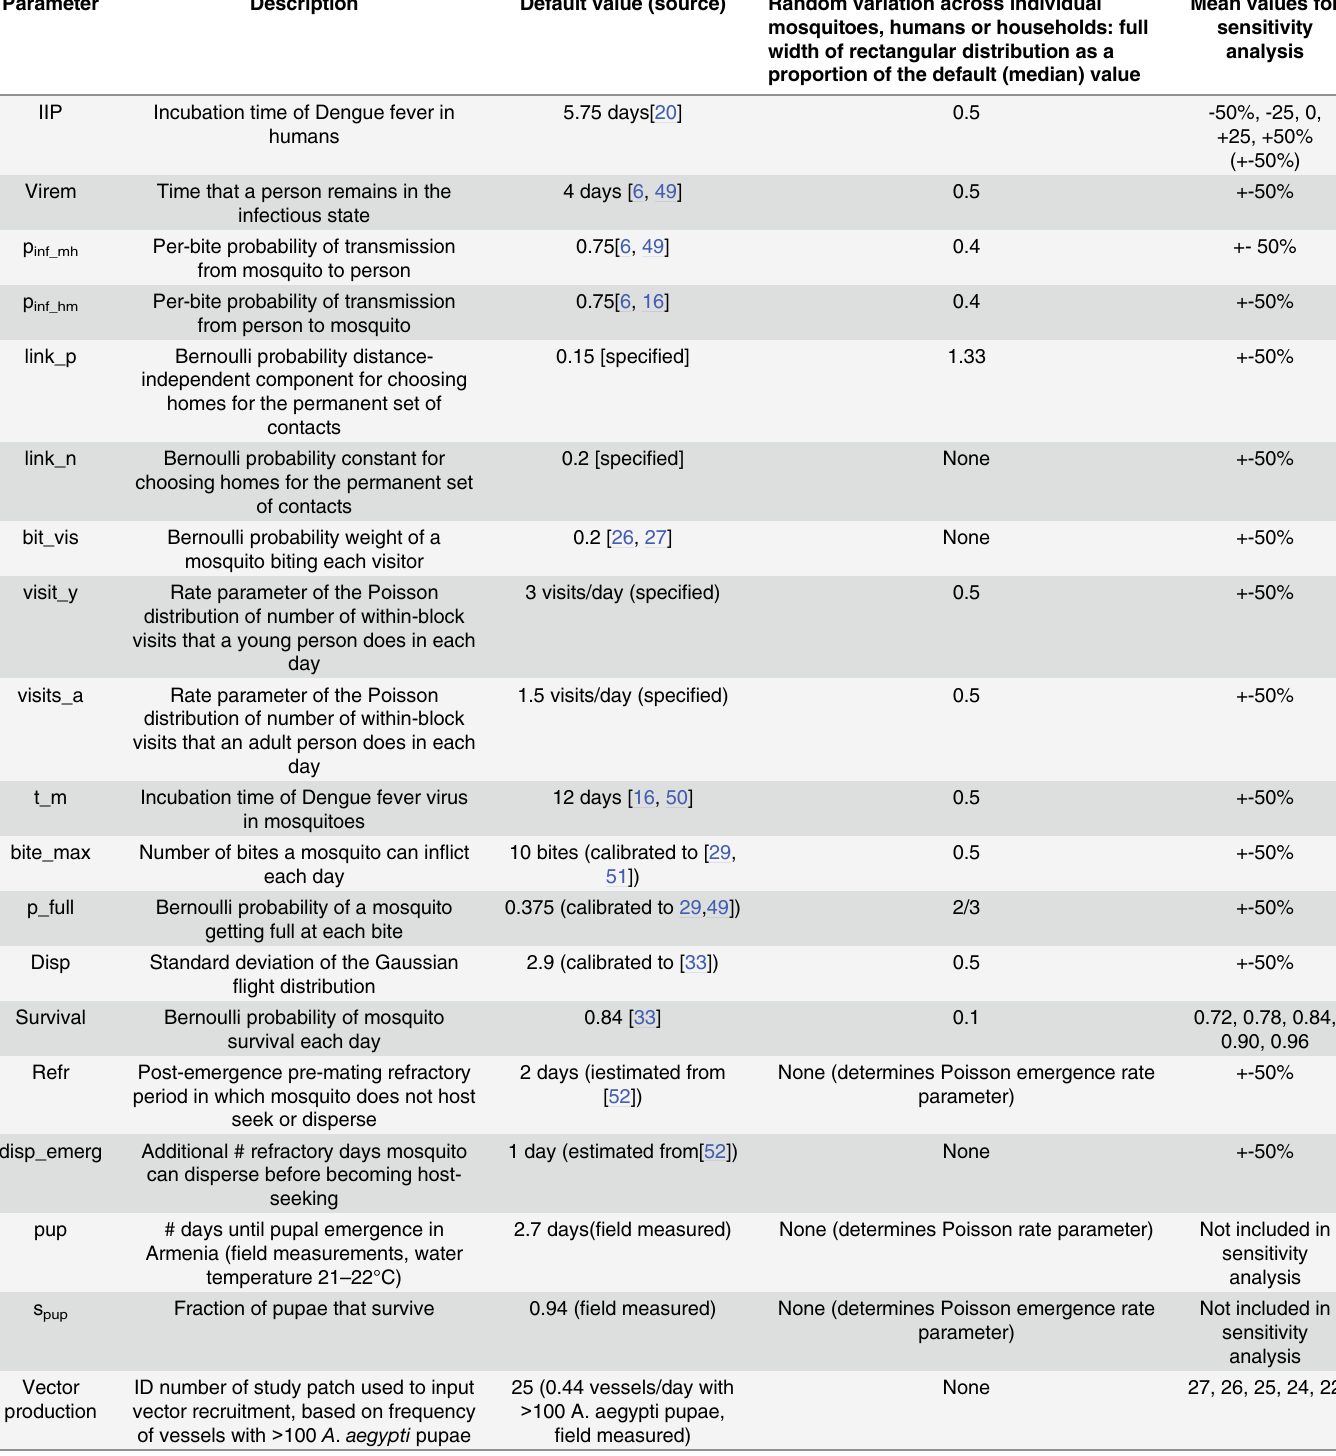
Table 2. Model parameters. Default value of a parameter refers to median value in all model analyses, with random individual-level variation as indicated in Table. Exceptions are mig , birth rate and vector production , which were jointly varied in initial analyses (see methods section for values)